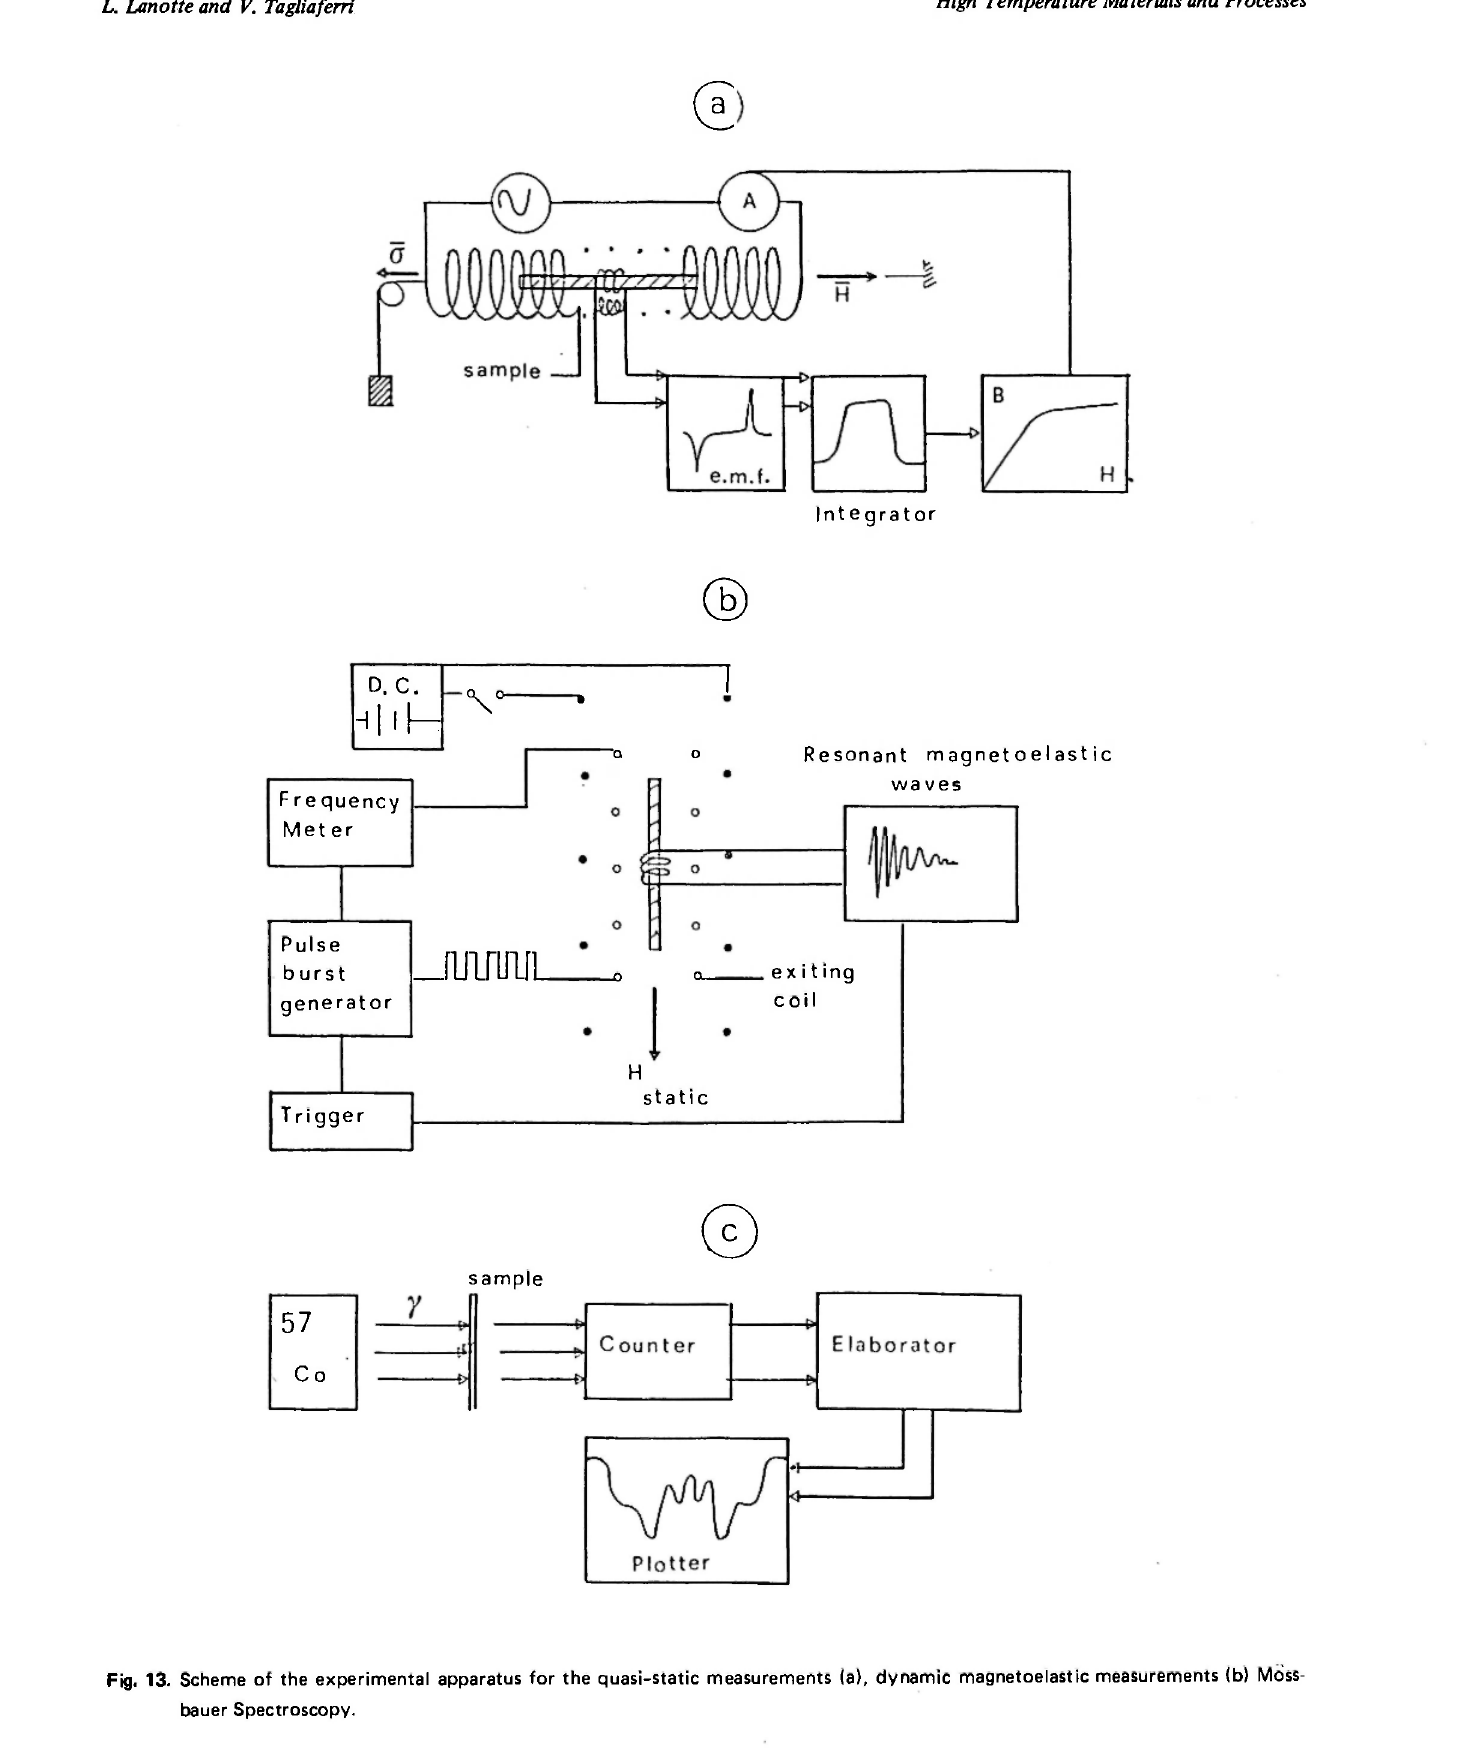
Fig. 13. Scheme of the experimental apparatus for the quasi-static measurements (a), dynamic magnetoelastic measurements (b) Mciss- bauer